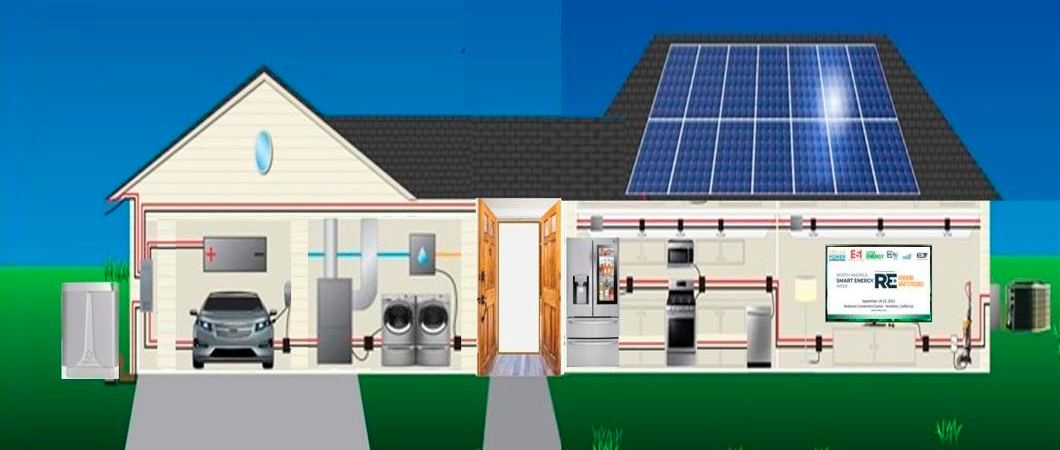
Figure 19. Hybrid bi-directional residential microgrid [126].